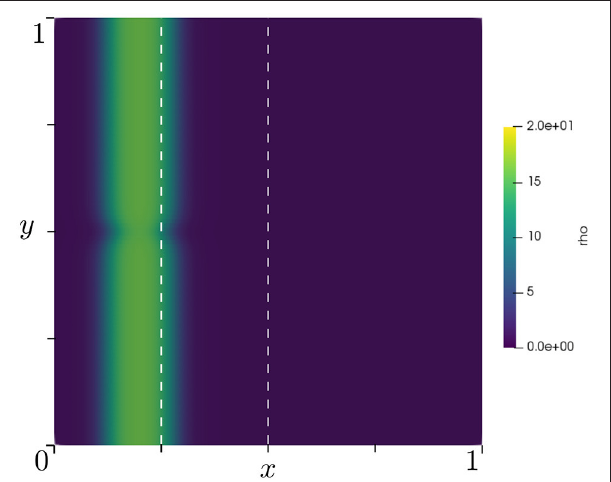
FIGURE 5 | Planar plasma switch domain and initial plasma density. Dashed lines denote the various decomposition points used. Mesh consists of 400 100 rectangles subdivided into two triangle elements.